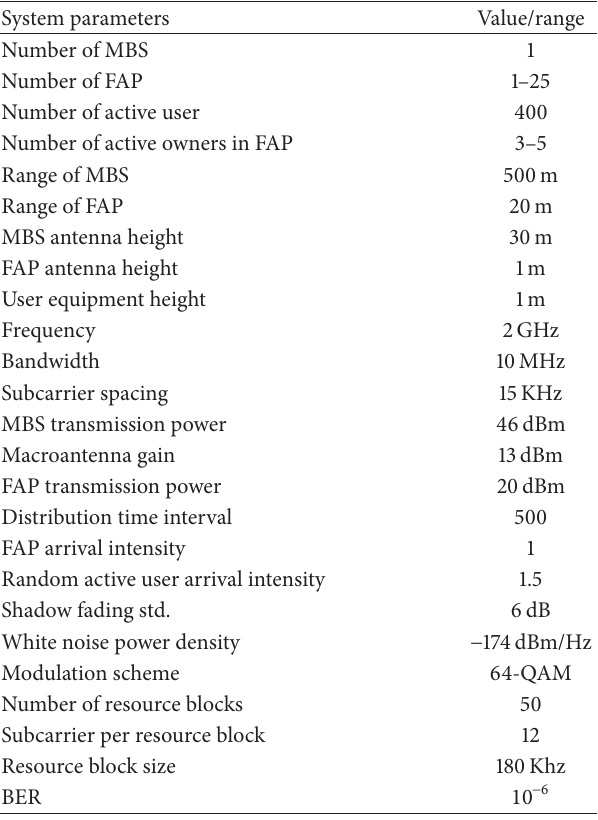
Table 1: System parameters.